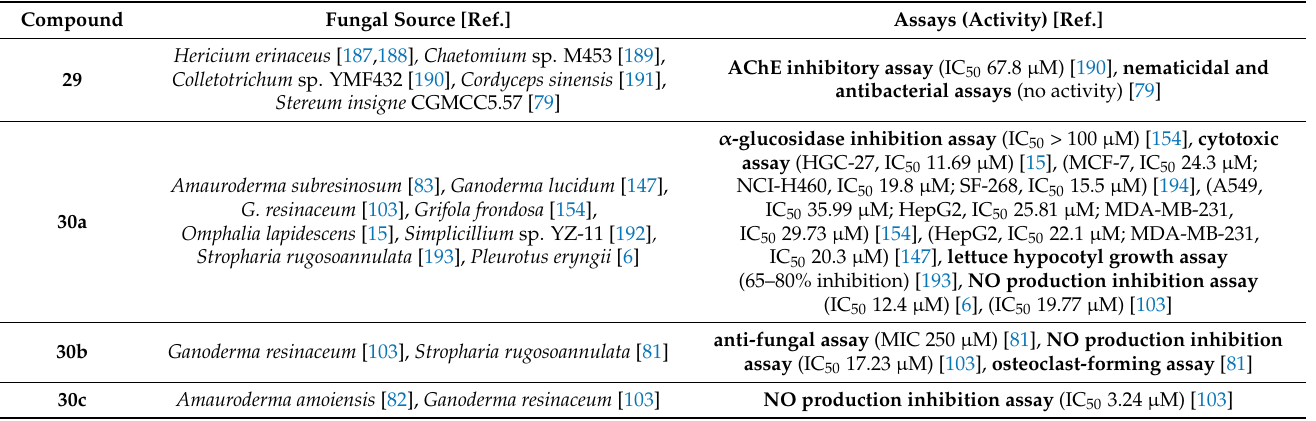
Table 2. Sources and biological activity of fungal epoxides. Fungal Source